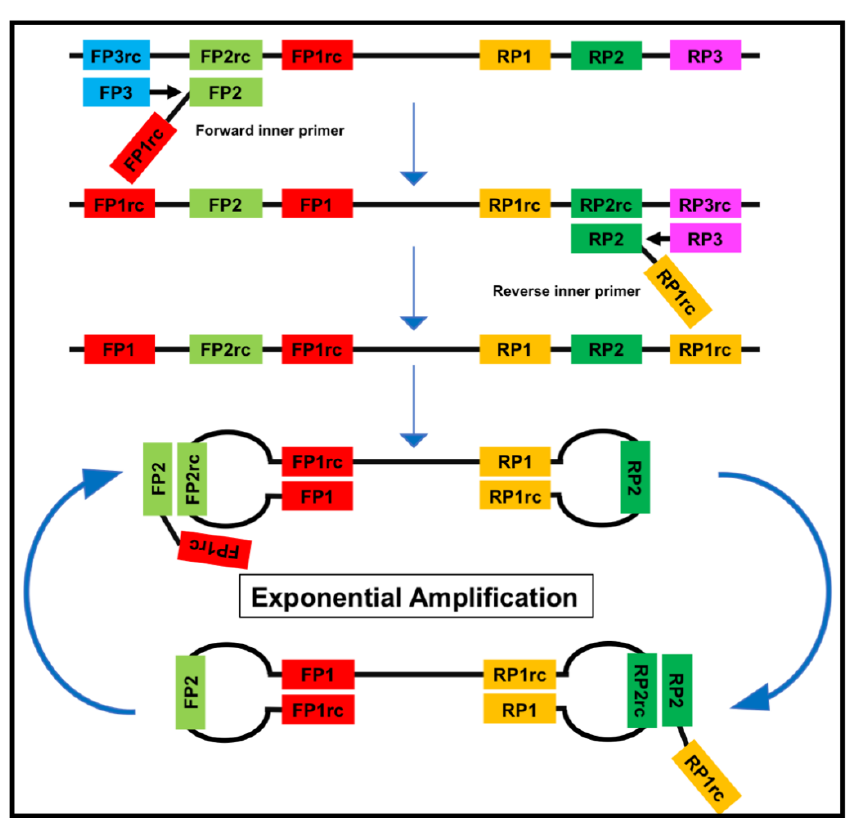
Figure 2. The loop-mediated isothermal amplification (LAMP) is based on a so called auto-cycling strand-displacement DNA synthesis using a strand-displacing DNA polymerase and two pairs of target-specific primers. The inner primers contain two sequences each corresponding to the sense and anti-sense (rc) strand of the target DNA, respectively, linked with a TTTT spacer. The inner primers initiate a complementary synthesis of the target DNA while the outer primers (FP1 and RP3) initiate a strand-displacement synthesis resulting in the release of single-stranded DNA linked by inner primers. The single-stranded DNA forms stem-loops by self-annealing of the corresponding sequences and acts as template for exponential amplification [23] .